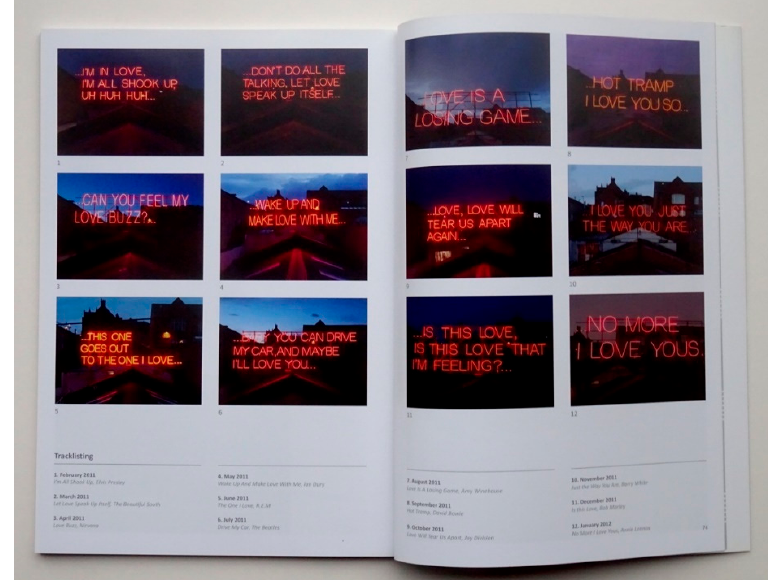
Figure 1. 12 Months of Neon Love 2011 (2012) by Victoria Lucas and Richard William Wheater. Photo by Charles Quick.